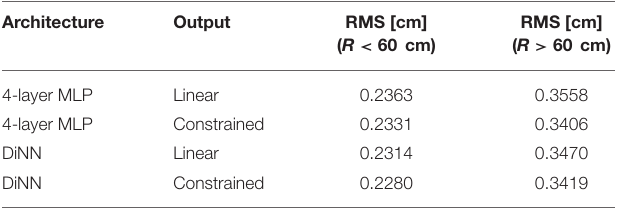
TABLE 2 | Results for different combinations of neural network architectures and output layers.